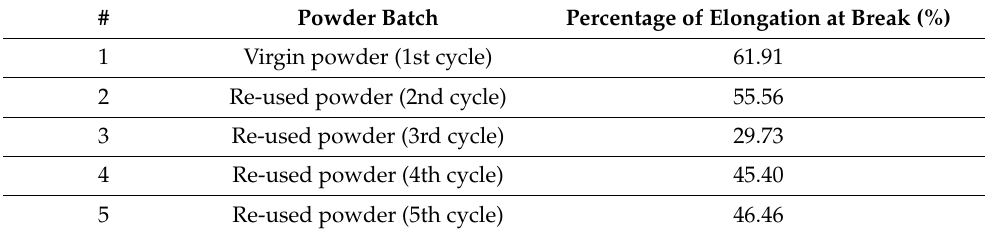
Figure 17. Ultimate tensile strengths of parts printed using Laser PP CP 75. In Figure 17, the tensile strength of the printed parts increased slightly, from 6.7 MPa to 7.4 MPa, with the re ‐ use of powder up to the 2nd re ‐ use cycle. After the 2nd re ‐ use cycle, the tensile strength value of the printed parts decreases to below that of the parts printed from fresh powder. Table 11. Young’s modulus of printed parts after 100% re ‐ use.